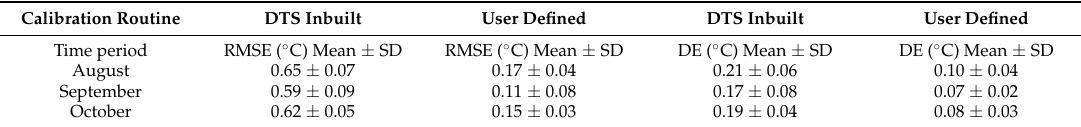
Table 1. Calibration statistics of RMSE and DE estimated at different time